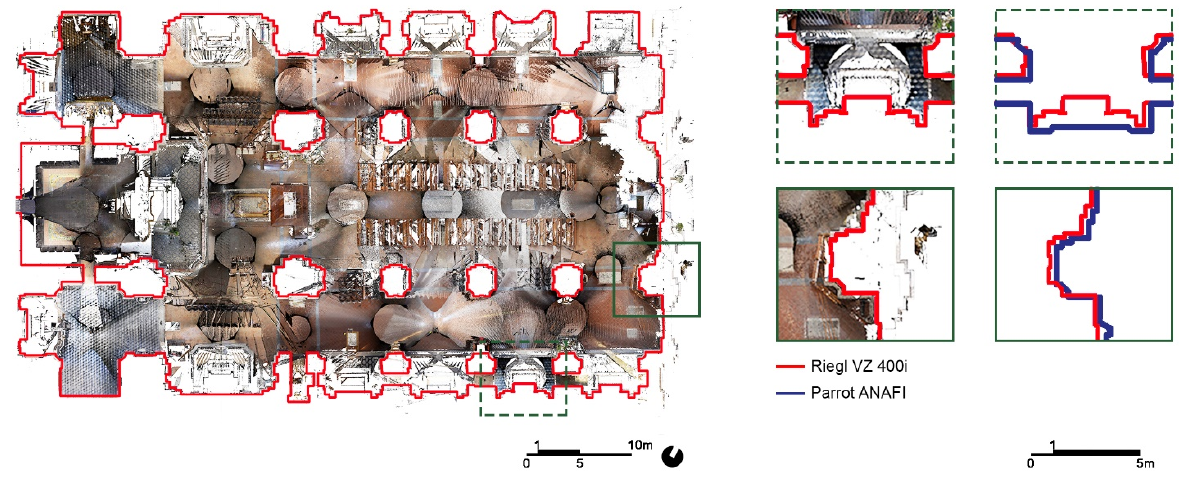
Figure 11. 2D comparisons between the profiles extracted from the range-based (Riegl VZ 400i) and the image-based point cloud (Parrot ANAFI